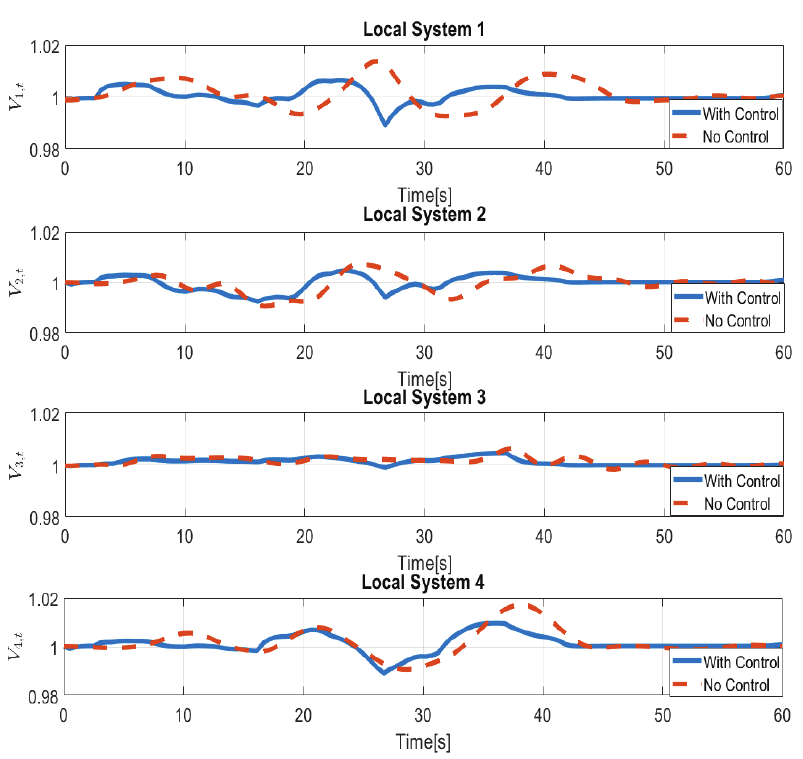
Figure 8. Voltage optimal results at each local system.